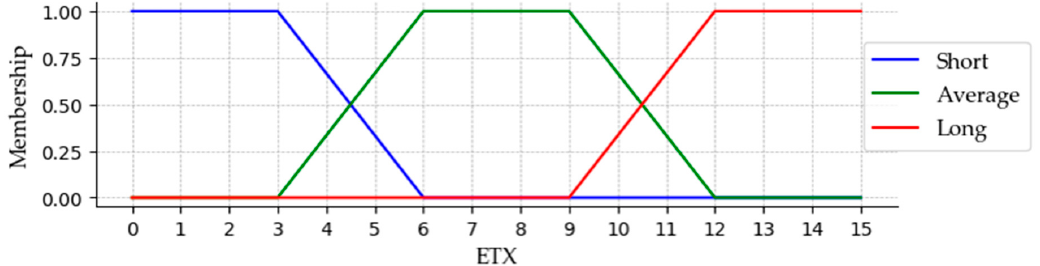
Figure 4. Input variable of expected transmission count (ETX ) . The variable represents the link quality of a path.